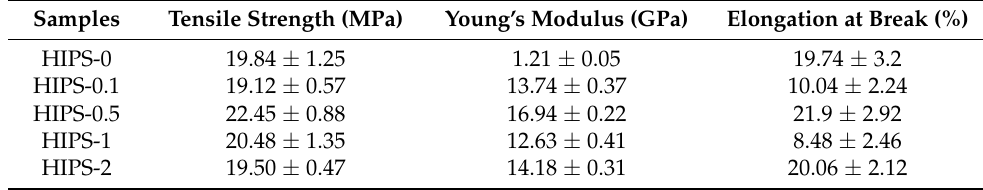
Table 3. Mechanical properties of tested